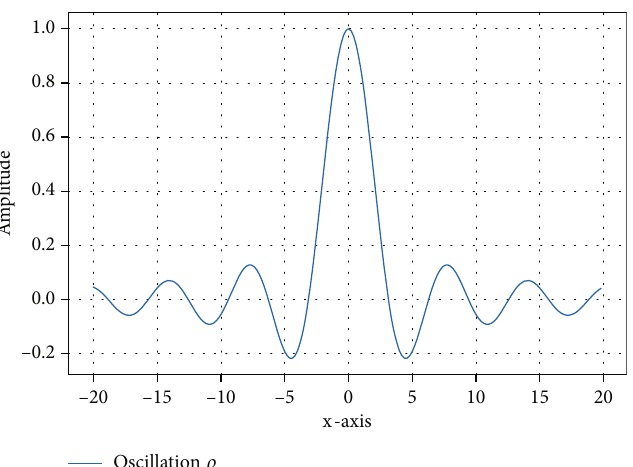
Figure 2: This fi gure shows the oscillation (Equation (32)) of a single spherical standing wave centred at the origin of the coordinates at time = 1 . Here any axis through the centre of the SCO can be taken as the x -axis, and due to spherical symmetry this t = 0 , with A 0 = 1 , k = 1 , c s ,0 oscillation is of this shape in any